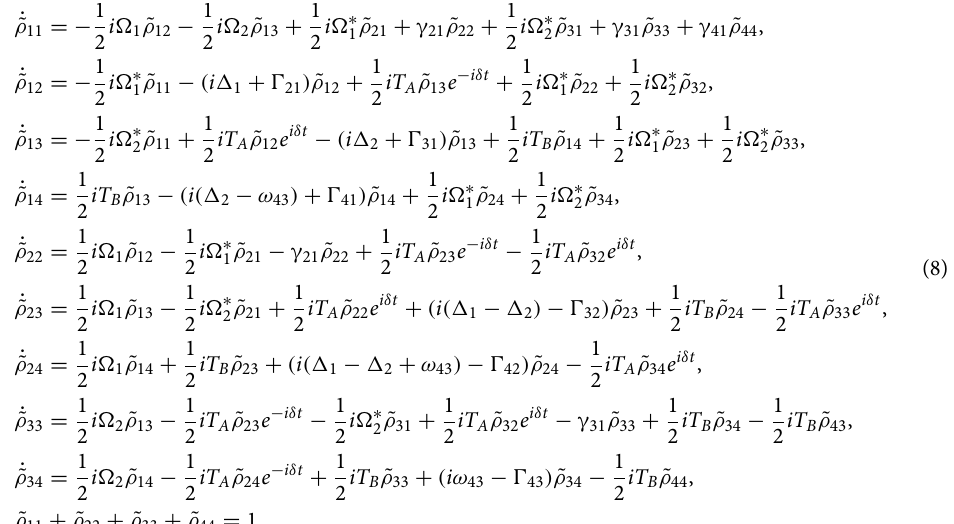
where L ρ represents the relaxation mechanisms such as spontaneous emission and pure dephasing terms that are added to the density matrix through represent the radiative decay and pure dephas- ij ing rates, respectively. In addition σ ij denote the transition operates. Thus, all the incoherent processes = | | that appeared in the density matrix element are imported through the parameters L ρ defined in Eq. (7). Substituting Eqs. (6) in Eq. (7) provides the density matrix elements